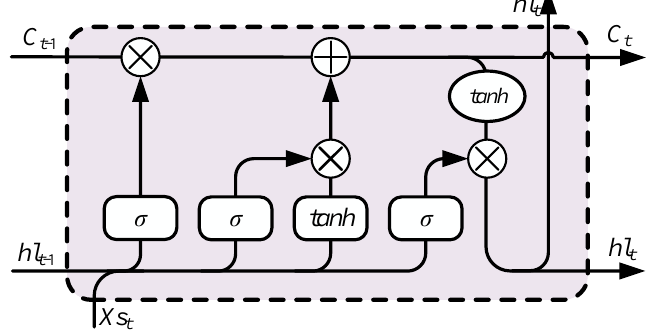
Figure 4. Structure of long short-term memory (LSTM).